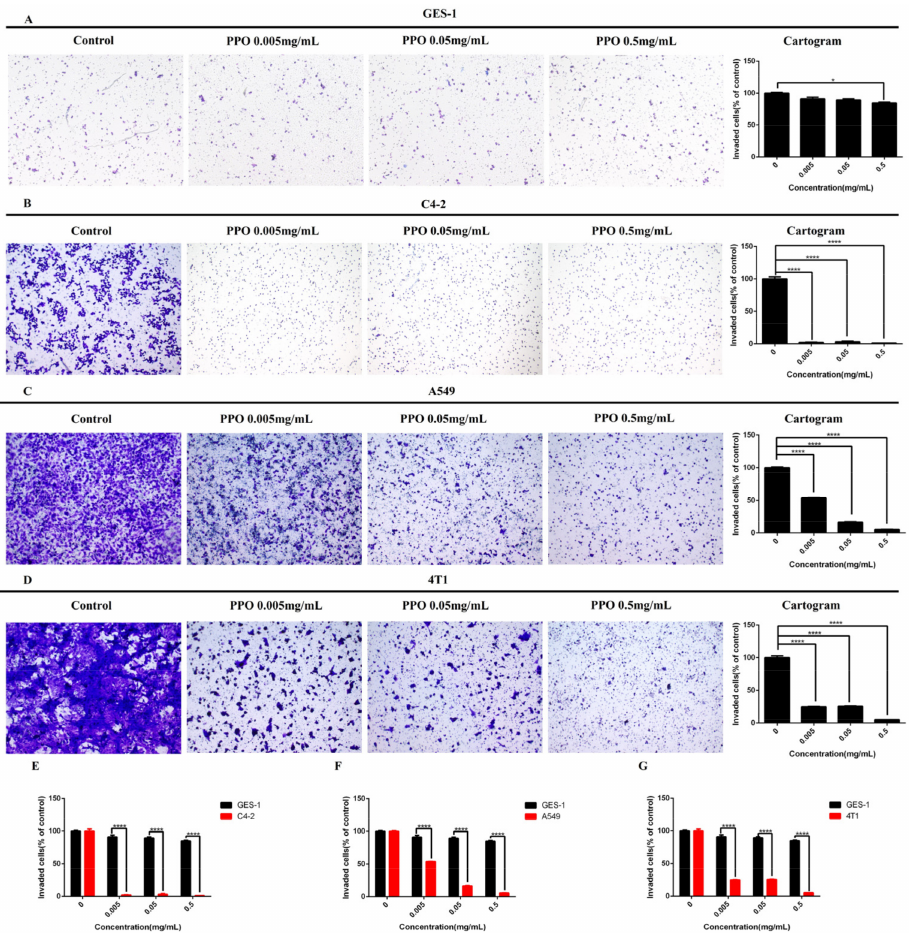
Figure 2. Effect of PPO on the invasion of ( A ) human gastric normal cell GES-1, ( B ) prostate cancer cell C4-2, ( C ) lung cancer cell A549, ( D ) breast cancer cell 4T1. Comparison of the effects of PPO on the invasion of ( E ) prostate cancer cell C-2, ( F ) lung cancer cell A549, ( G ) breast cancer cell 4T1 and human gastric normal cell GES-1; bars, SE (* p < 0.05; **** p < 0.0001 versus